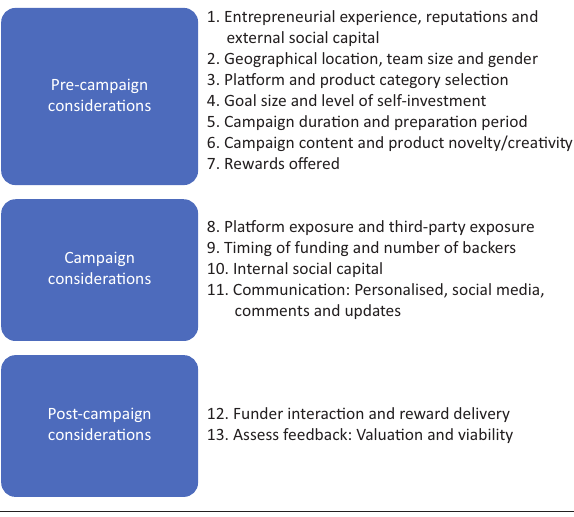
FIG URE 1: Crowdfunding key success factors